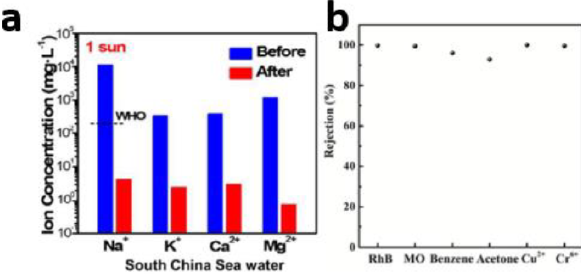
Figure 12: (a) Changes of four main ions in seawater before and after solar desalination [130]. (b) Rejection performance of organic and heavy metal ions